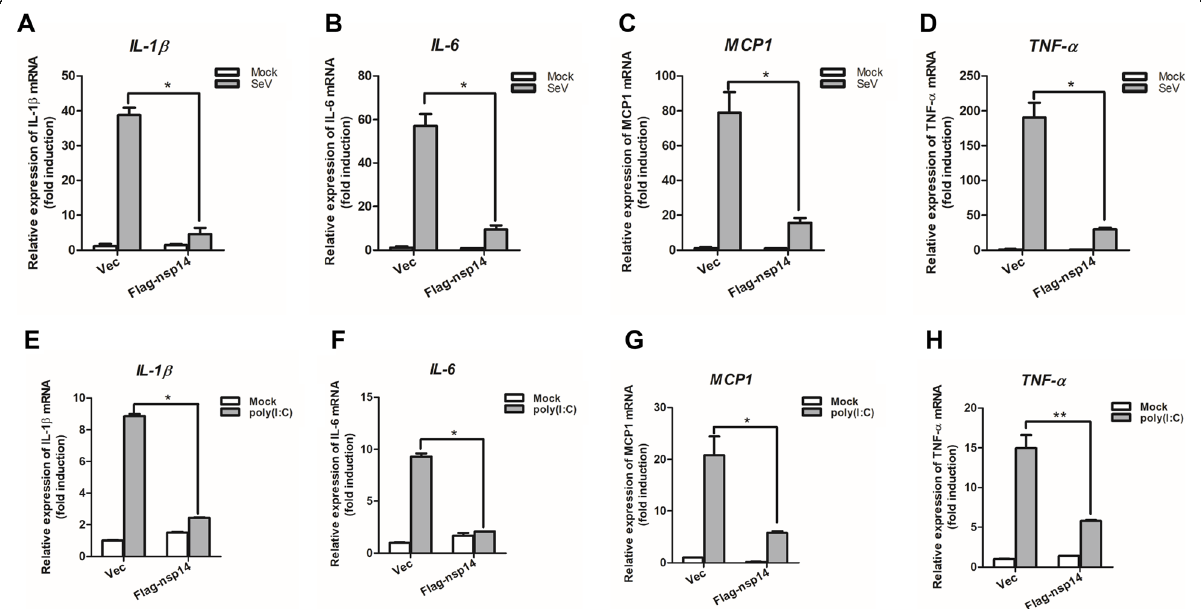
Fig. 2 PEDV nsp14 suppressed the expression of proinflammatory cytokines in HEK293T cells. A-D HEK293T cells were transfected with 1 μ g vector plasmids or Flag-nsp14 expression plasmids. At 24 hpt, cells were infected with SeV for 16 h, andmRNA levels of IL-1 β ( A ), IL-6 ( B ), MCP1 ( C ) and TNF- α ( D ) were measured via qPCR analysis. E-F HEK293T cells were transfected with 1 μ g vector plasmids or Flag-nsp14 expression plasmids. At 24 hpt, cells were transfected with 1 μ g poly (I:C) for 12 h, and mRNA expression levels of IL-1 β ( E ), IL-6 ( F ), MCP1 ( G ), and TNF- α ( H ) were measured via qPCR analysis. *, P < 0.05 ; **, P <